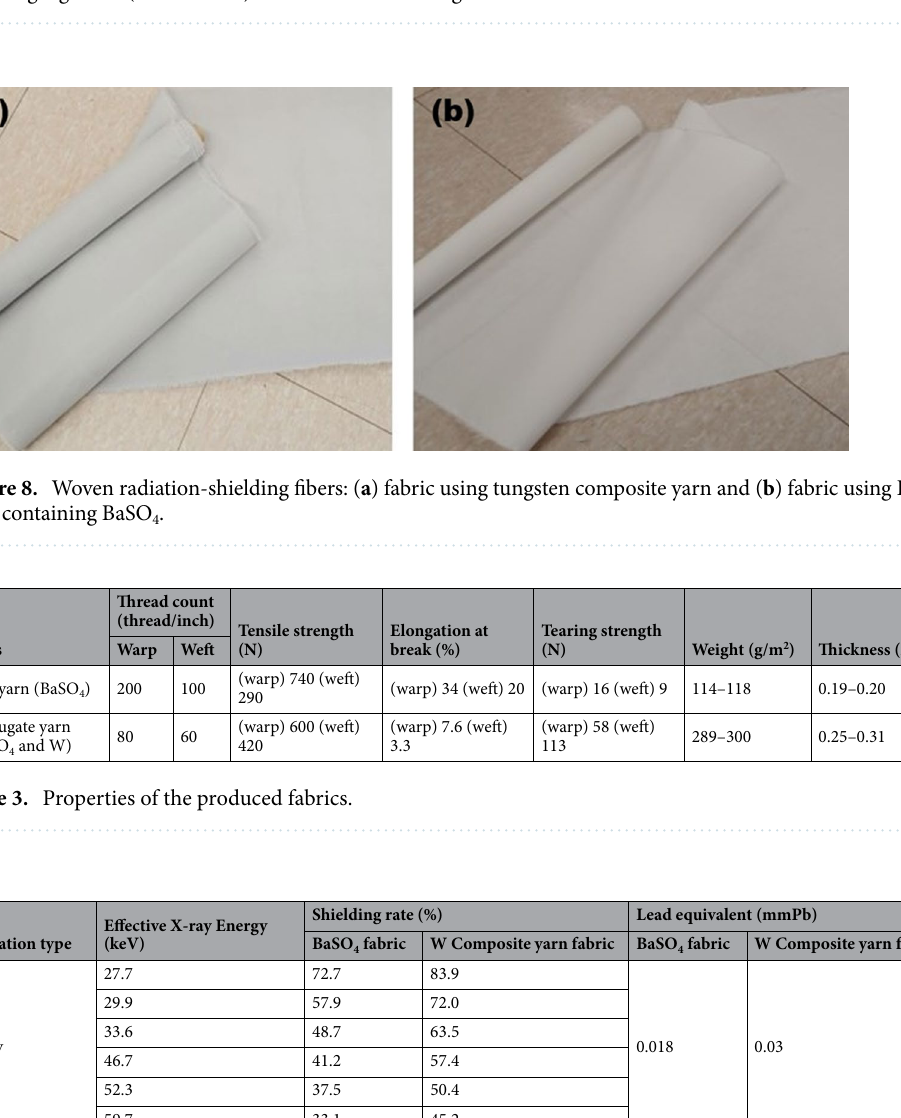
Table 2. Characteristics of composite yarn with a double covering of polyester (PET) fiber containing barium sulfate on a tungsten wire core. a Denier (D): the unit of thickness of fiber, with 1D being 9,000 m of thread